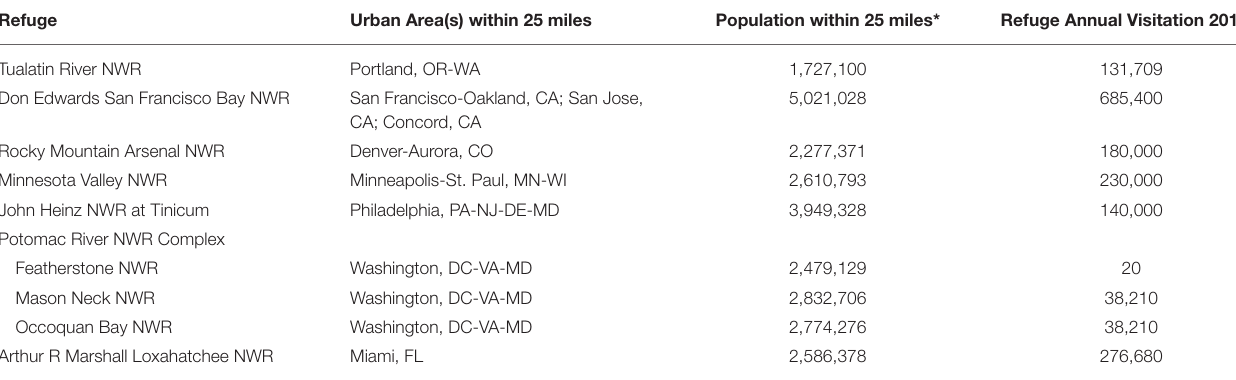
TABLE 1 | National Wildlife Refuges (NWR) selected for participation in community workshops.